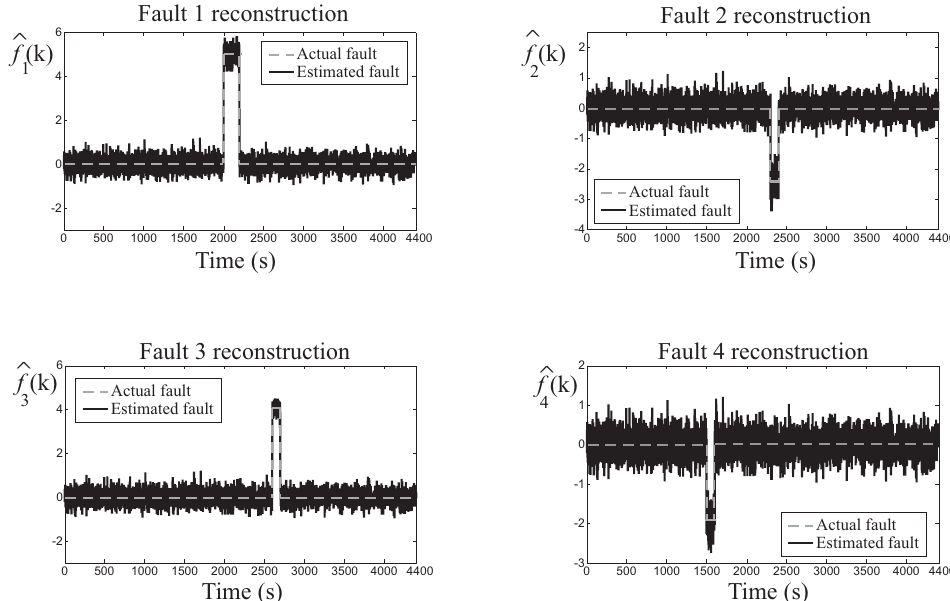
Figure 5. Reconstructed and actual faults for cases 1, 2, 3, and 4.